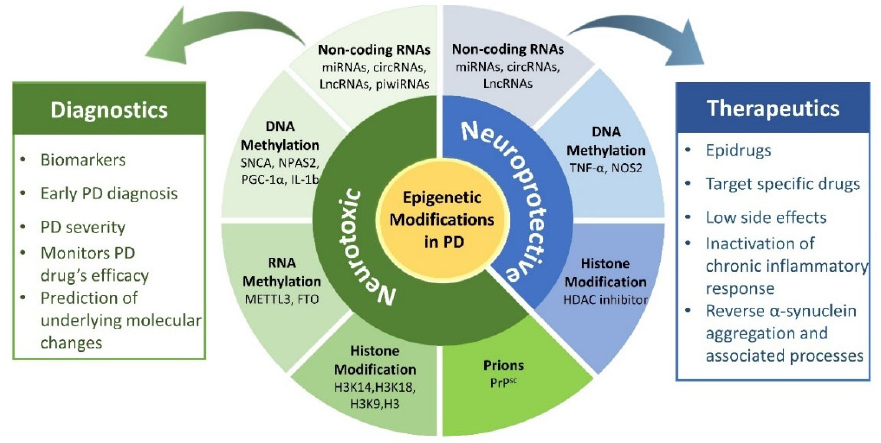
Figure 7. Proposed applications of neurotoxic and neuroprotective epigenetic modification in Parkinson’s disease management. Neurotoxic epigenetic modifications can be utilized for PD diagnosis. In contrast, neuroprotective epigenetic modifications can be utilized for PD therapeutics.